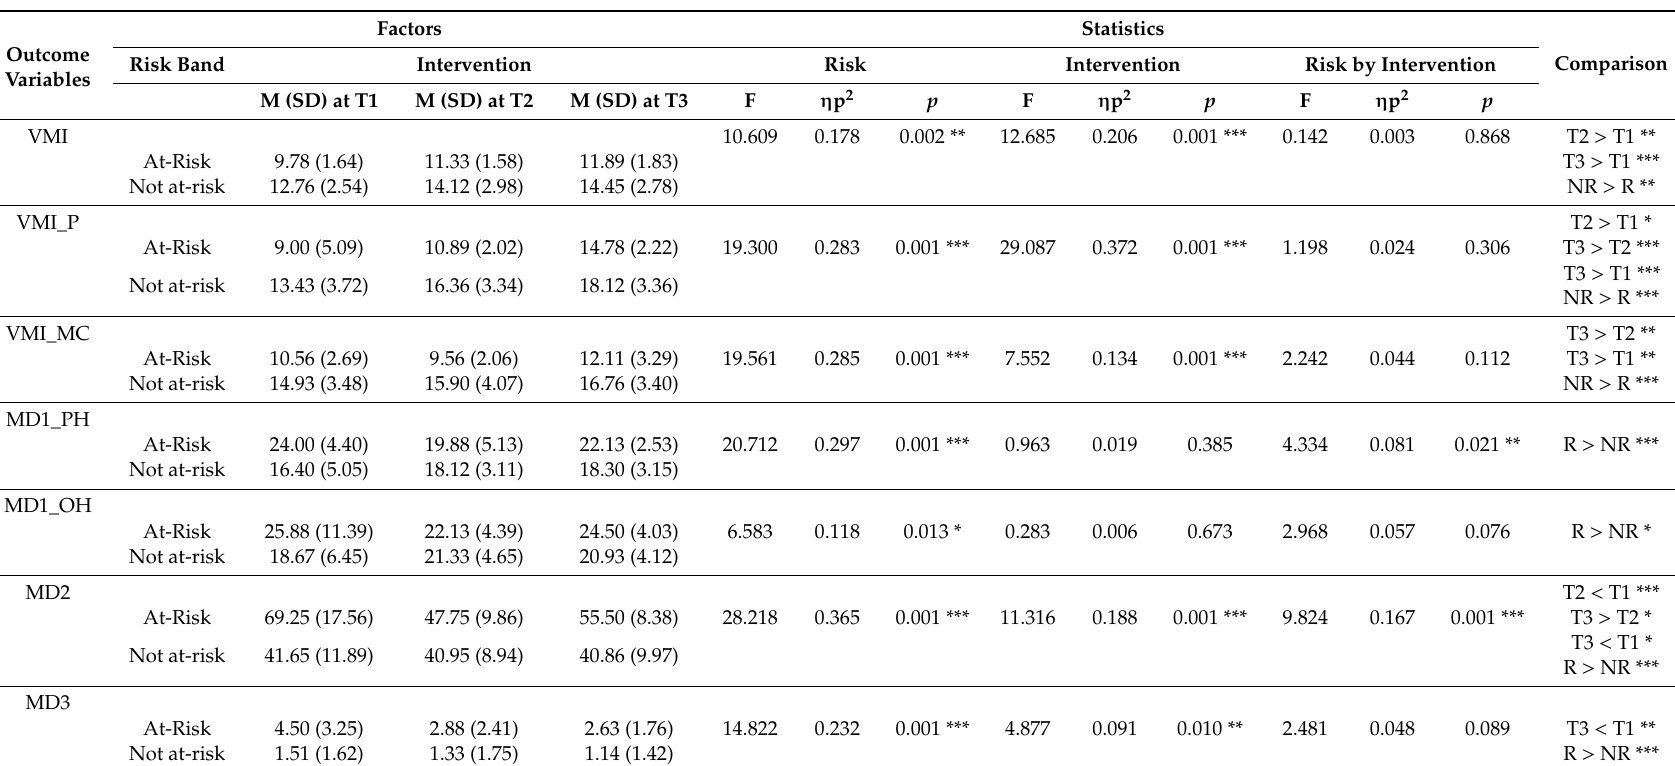
Table 6. Means and SD for the main outcome variables and partial eta-squared values associated with risk bands and time-intervention factors. Factors Outcome Variables